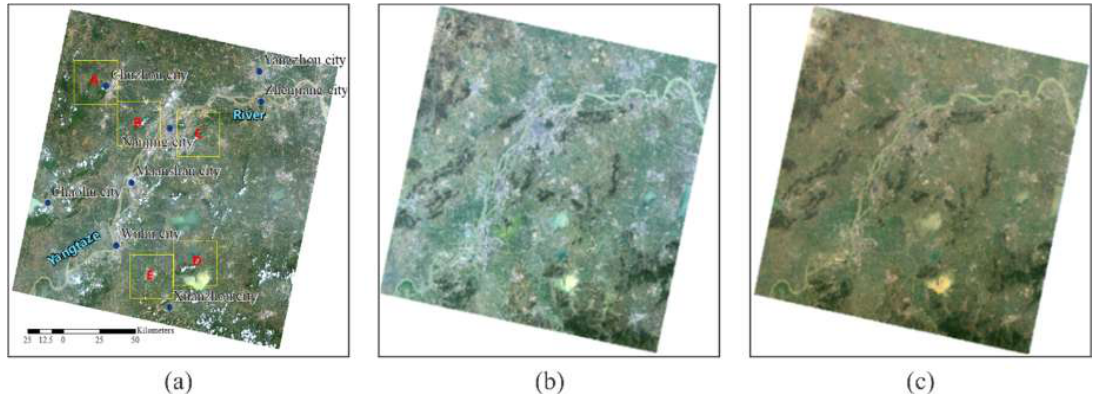
Figure 7. Applying the LRM approach to the OLI image located in Southeast China near Nanjing City. ( a ) The target image captured on 29 April 2016 with five subset test areas (bands 4, 3 and 2 composited) containing di ff erent land cover patterns. ( b , c ) The reference images acquired on 28 March and 12 March 2016 were used to reconstruct the cloudy areas.